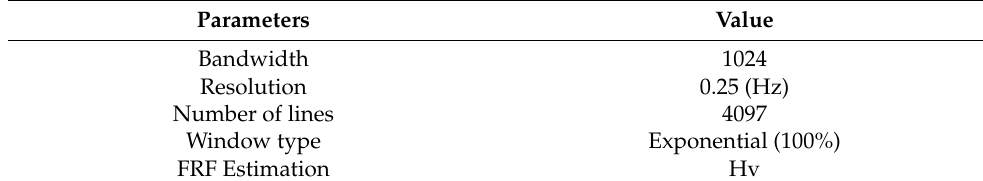
Table 7. Parameter setting for FRF analysis.